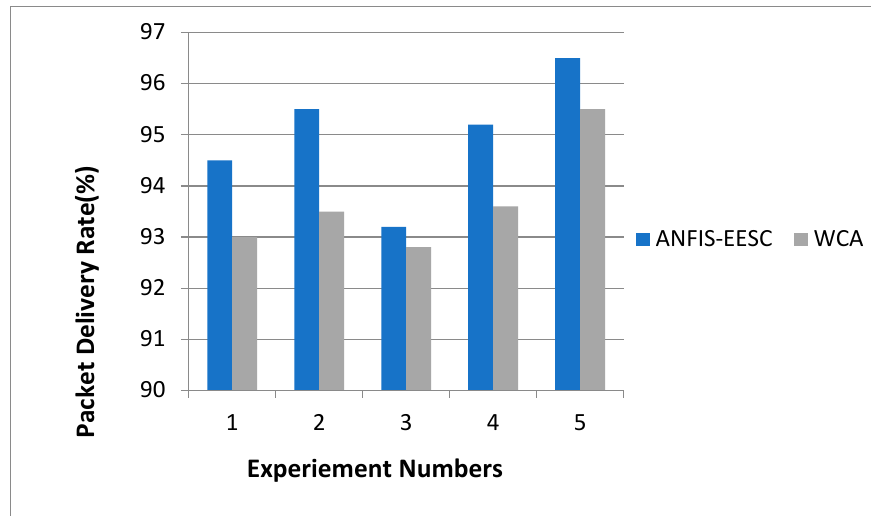
Figure 3. Packet delivery rate analysis.